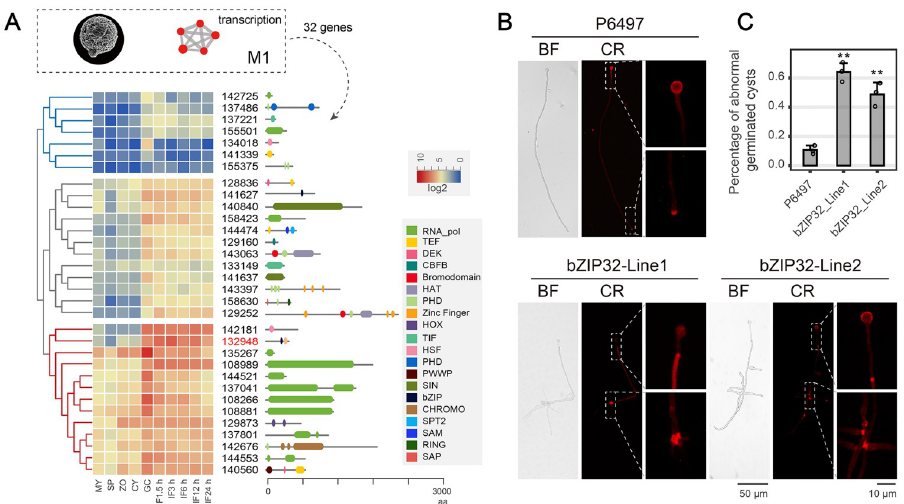
Fig 5. A bZIP transcription factor (bZIP32) required for cyst germination in P . sojae . (A) Hierarchical clustering of mRNA levels of genes involves in transcription activity in the first Module. And also the domain structures of included genes were displayed on the right panel. (B) Observation of germinated tubes at 8 h after zoospores encysted. Cysts from wild-type (WT) and bZIP32 silenced mutants (bZIP32-Line1 and bZIP32-Line2) were incubated at 25˚C for 8 h and photographed. Bar, 50 μ m. (C) The morphologies of germinated cysts were observed under a microscope, and the ratio of abnormal germinated cysts to the total number of cysts was calculated. All experiments were repeated three times with similar results. ** Significant difference at p < 0 . 01